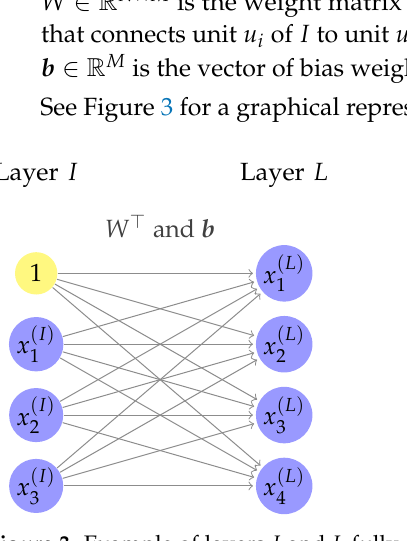
Figure 3. Example of layers I and L fully connected, made of 3 and 4 units, respectively. The bias unit is highlighted in